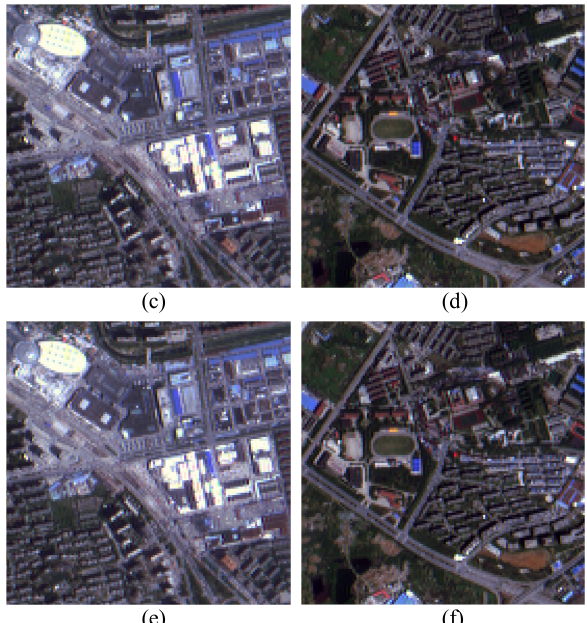
Figure 10 . Two regions of the image. (a) and (b) is the original image of each region without treatment, respectively. (c) and (d) is the restored image of each region using correlation coefficient and least squares matching during jitter compensation, respectively. (e) and (f) is the restored image of each region using phase correlation matching during jitter compensation, respectively.